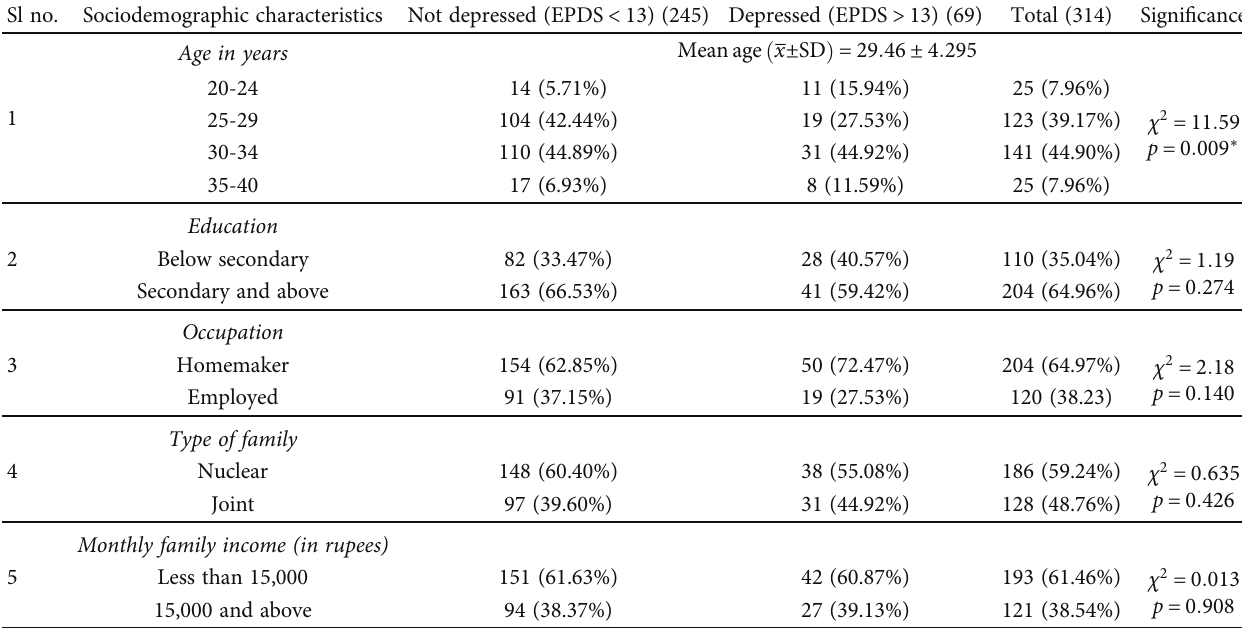
Table 1: Sociodemographic characteristics of the study